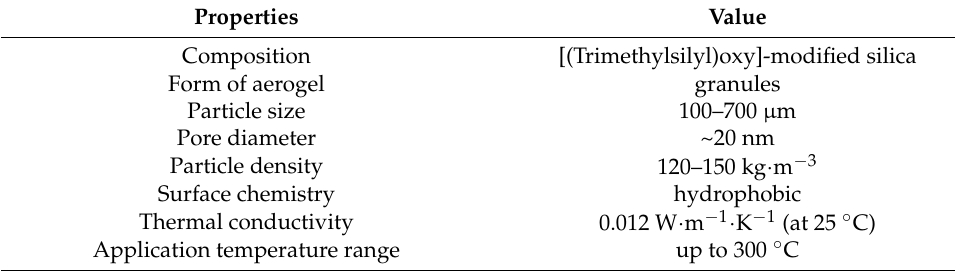
Table 1. Characteristics of silica aerogel [48].